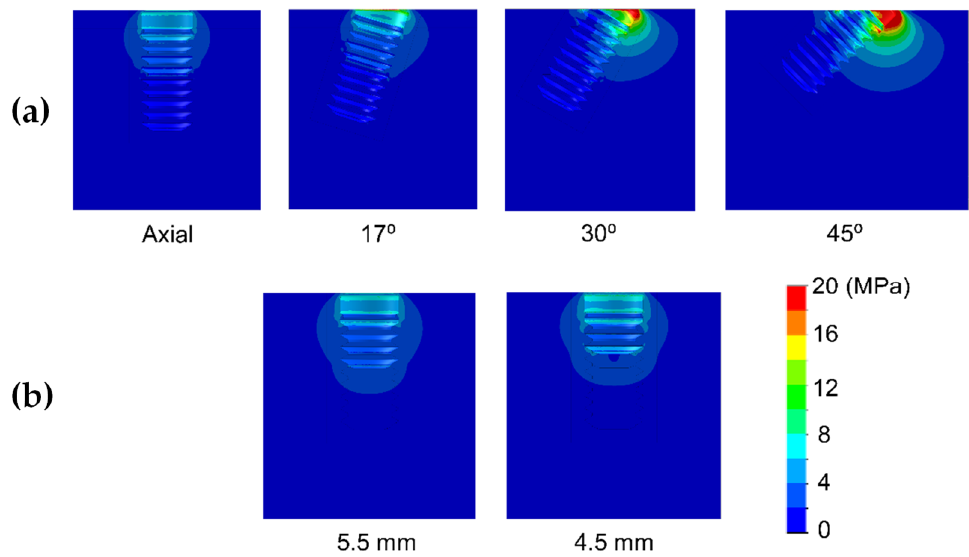
Figure 9. Von Mises stress distribution of delay-loaded long 10 mm implant ( a ) and short implants (4.5 and 5.5 mm in length) ( b ) in bone type 0-I.